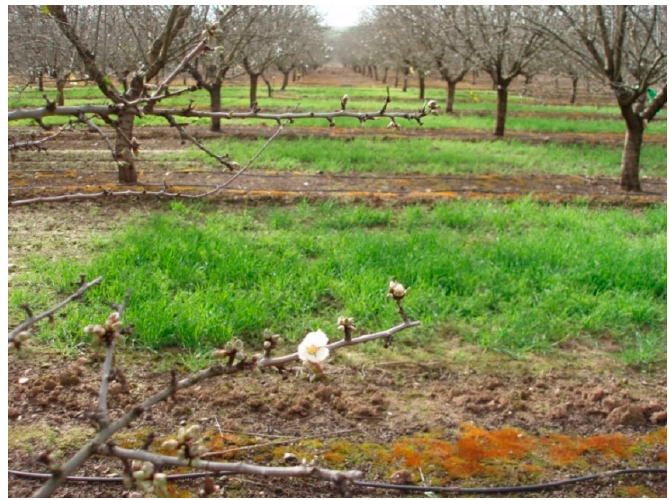
Figure 1. Experimental plot during almond flowering (February 2017).